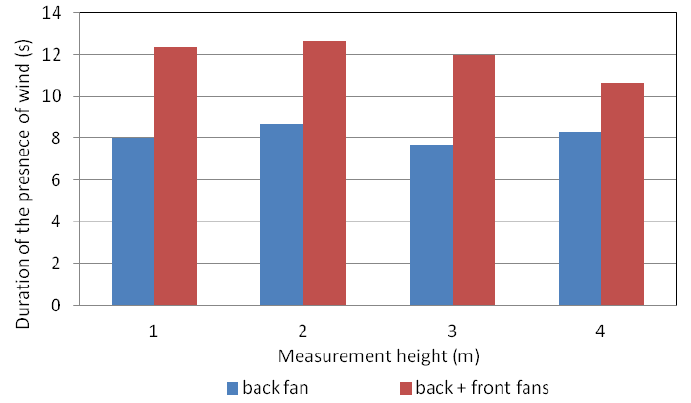
Figure 14. Dynamic test. Duration of the presence of wind in the machine vicinity. Measurement conditions: distance = 2.5 m; fan blades position = 3; heights = 1, 2, 3 and 4